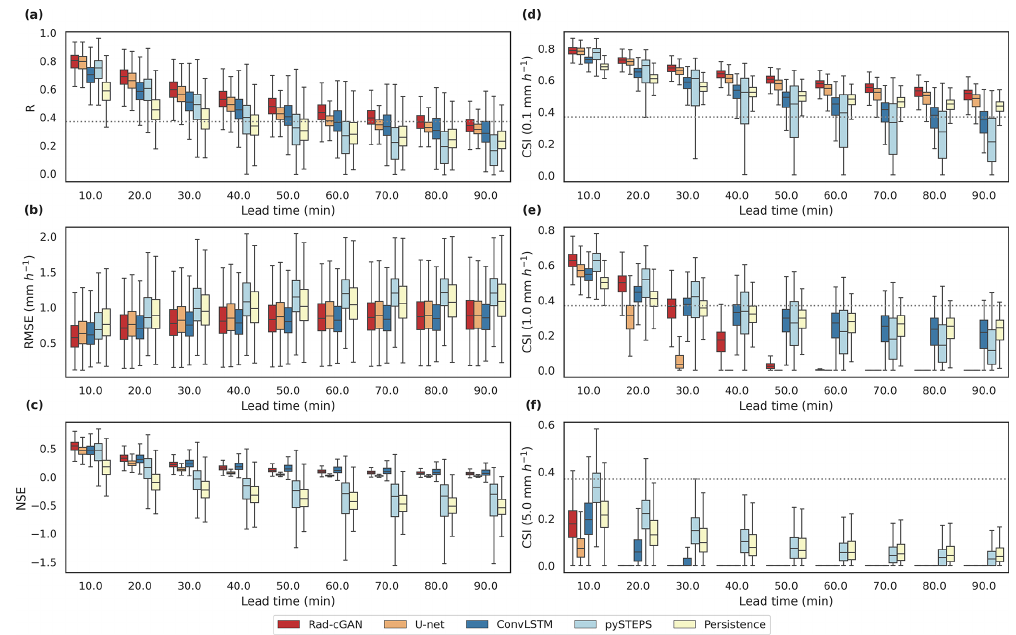
Figure 3. Box plots of the verification metrics of model predictions at the lead time up to 90min over all grid cells from the Soyang-gang Dam basin. From top to bottom, (a) – (c) represent R , RMSE, and NSE, and (d) – (f) represent the CSI at intensity thresholds of 0.1, 1.0, and 5.0mmh − 1 . Dotted gray line represents the predictability threshold (1 /e